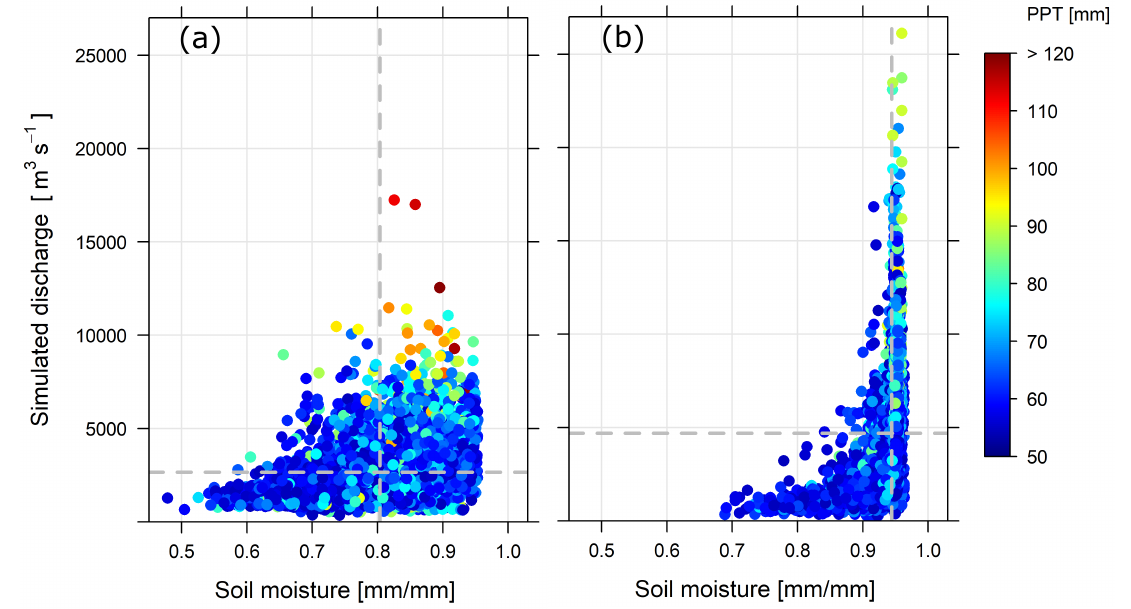
Figure 6. 10-day mean of soil moisture plotted against the corresponding discharge at the end of each 10 day interval, shown for 10-day precipitation events exceeding the 95% quantile for ( a ) summer (Mar–Sep) and ( b ) winter (Oct–Mar). The color scale represents the 10-day sum of precipitation (PPT) for the events shown. The dashed line represents the mean of the points for soil moisture and